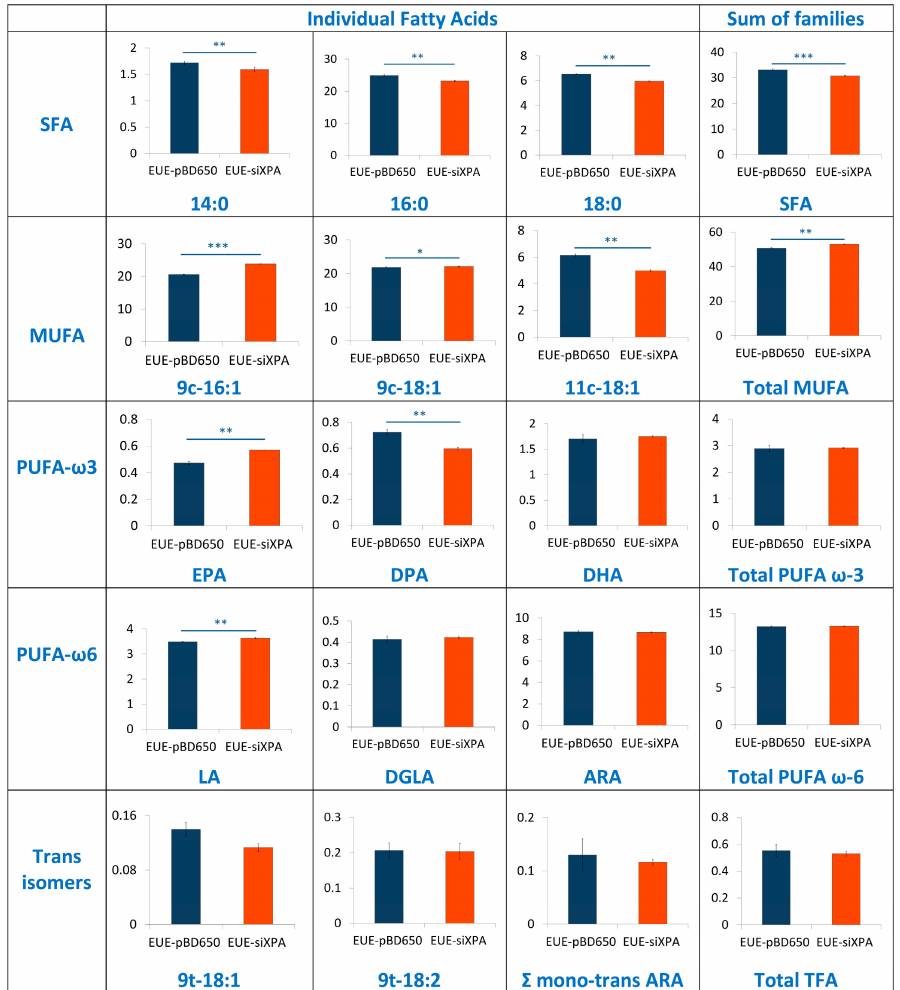
Figure 6. Percentage di ff erences presenting comparison between EUE-pBD650 (wt) and EUE-siXPA cell membranes. The values are given as mean ± SD ( n = 3). Each member of the fatty acid family is given in a row, the last column is the sum of the corresponding fatty acid family. Values significantly di ff erent from wt cells: (*) p < 0.05, (**) p < 0.01, (***) p < 0.001. For specific values see Table S12. Asterisks indicate the significance of di ff erences between wt and deficient